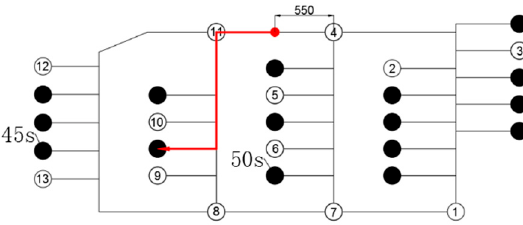
Figure 11. Real-time condition 3 of the parking lot.